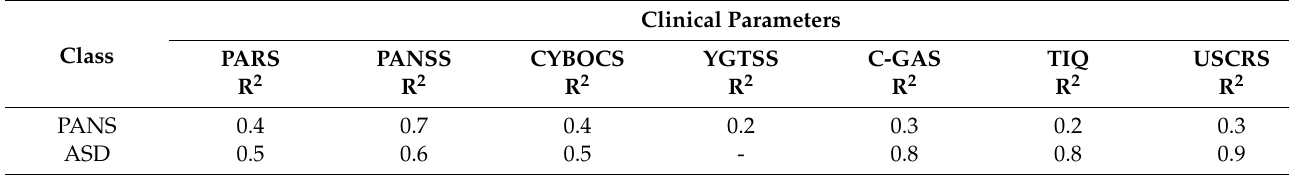
Table 4. Statistical results of the PLS correlation